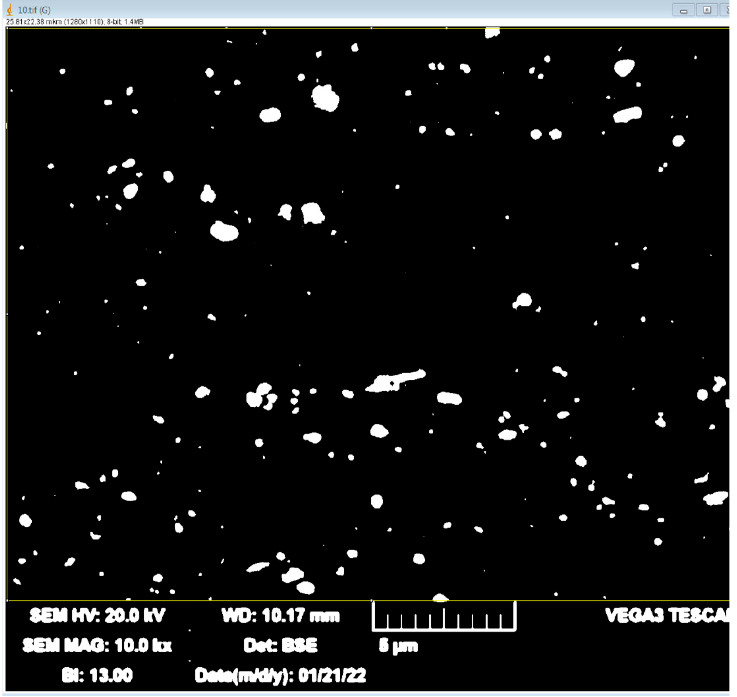
Figure 12. Scanning electronic microscopy of the 5Mg0.5Mn0.5Cu alloy.